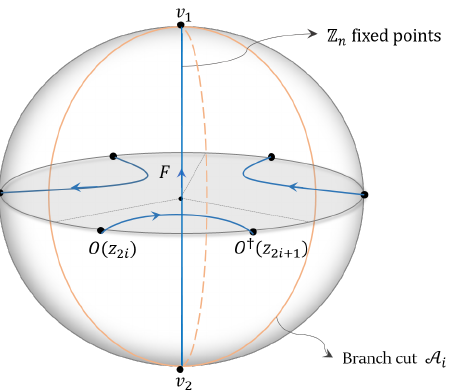
Figure 2. For the complex plane with a single interval as the entanglement region, the correspond- ing n -sheeted branched covering is still a Riemann sphere. The defect in the bulk replica manifold runs along the locus of the Z n fixed points. The operators O denote the current primary fields for the original CFT states, which generate the background gauge fields. They are taken to be n copies on the replica